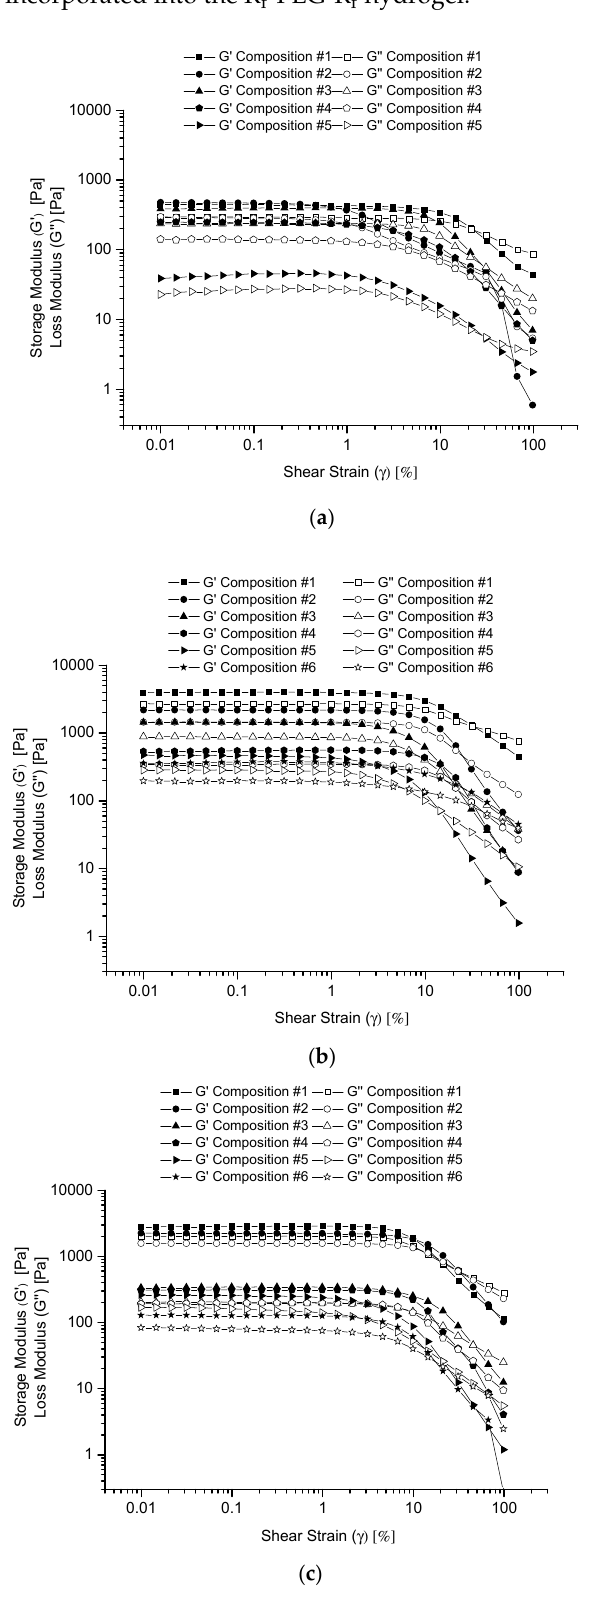
Figure 3. G’ and G’’ versus γ curves (in logarithmic scales) for the given co-hydrogels prepared in water ( a ), PBS buffer ( b ) and glycine/NaOH buffer ( c ). water ( a ), PBS buffer ( b ) and glycine/NaOH buffer ( c